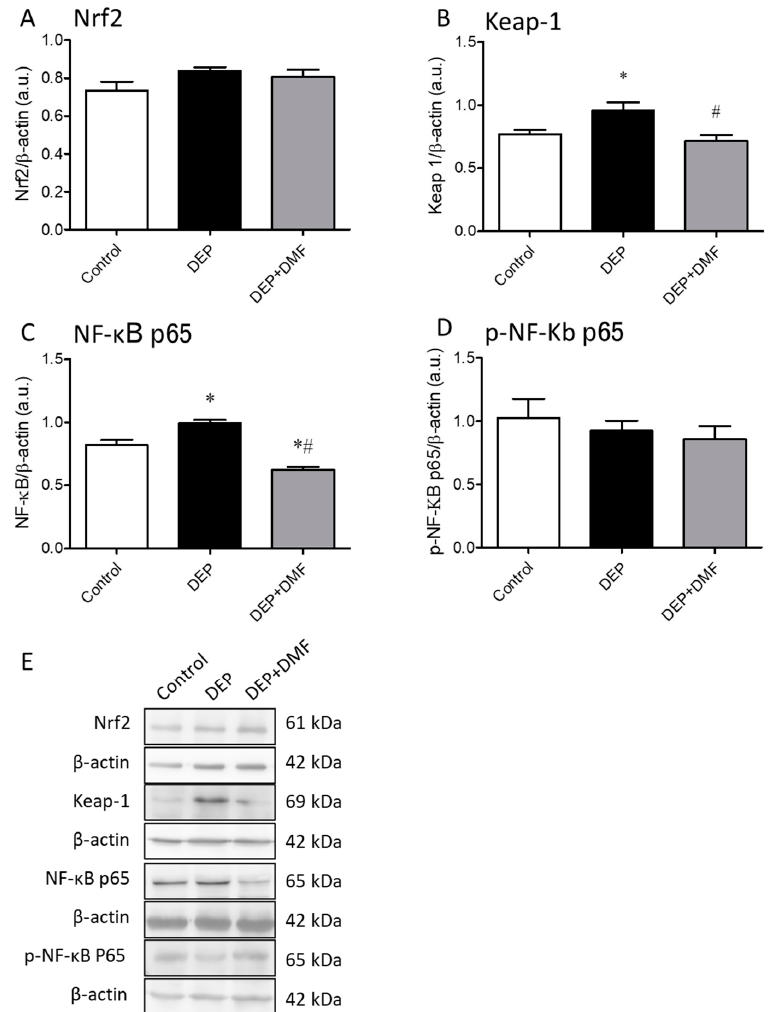
Figure 3. Densitometric comparison of nuclear factor erythroid 2-related factor 2 (Nrf2, ( A )), kelch- like ECH-associated protein 1 (Keap-1, ( B )), total nuclear factor kappa B p65 (NF- κ B, ( C )), phospho-nuclear factor kappa B p65 (p-NF- κ B p65, ( D )) protein expression in mouse lungs after exposure to DEP for 60 consecutive days, with or without DMF treatment for the last 30 days. Representative immunoblots are shown in panel ( E ). The densitometry is expressed as arbitrary units (a.u.) and β -actin was used as a loading control for all immunoblots. Except for Keap-1 ( n = 6), data ( n = 3) are expressed as the mean ± SEM. * p < 0.05 vs. control group, # p < 0.05 vs. DEP